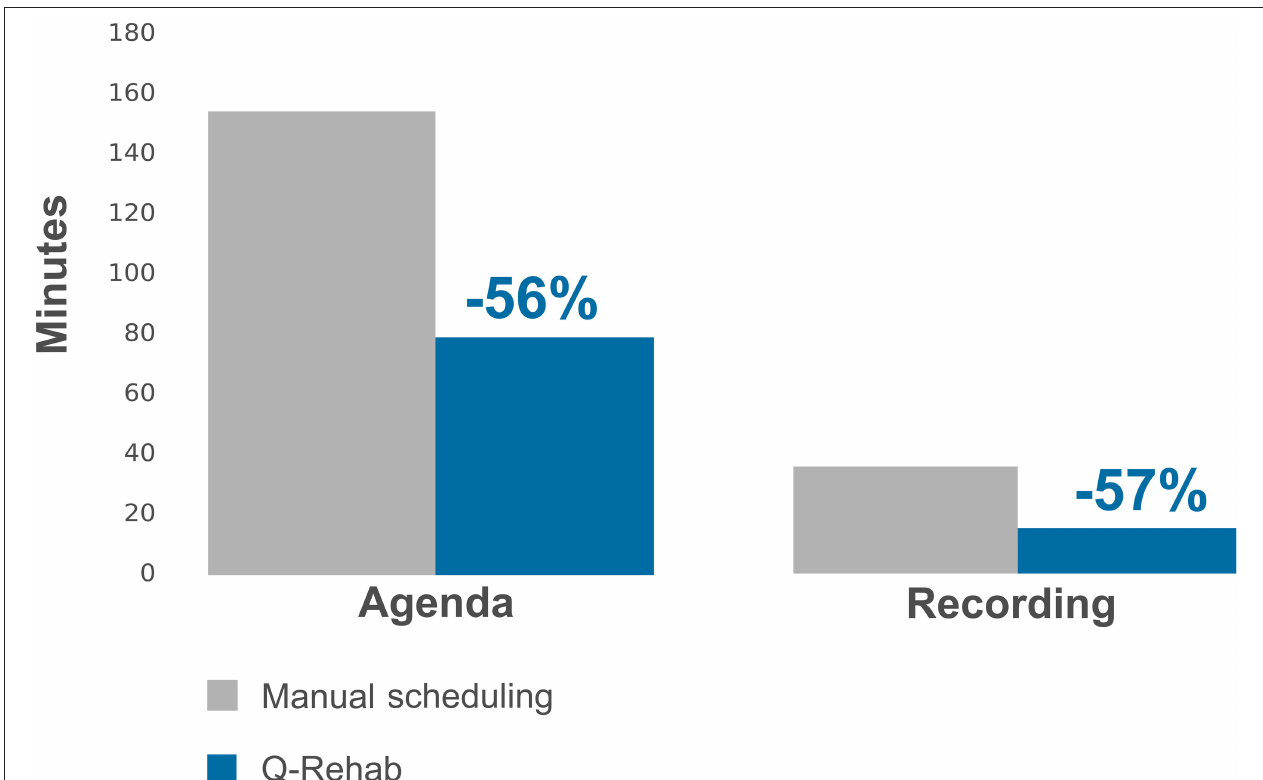
FIGURE 7 | Time saved in scheduling and recording therapy